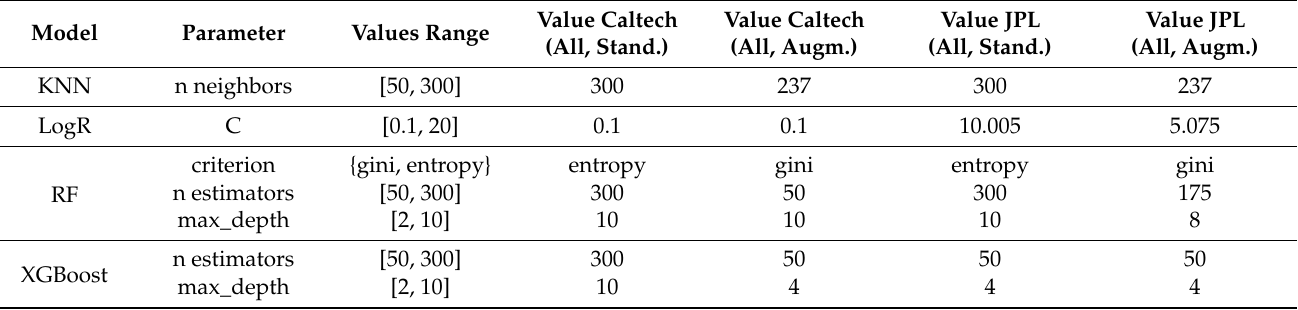
Table 4. Overview of classification hyperparameters used for grid